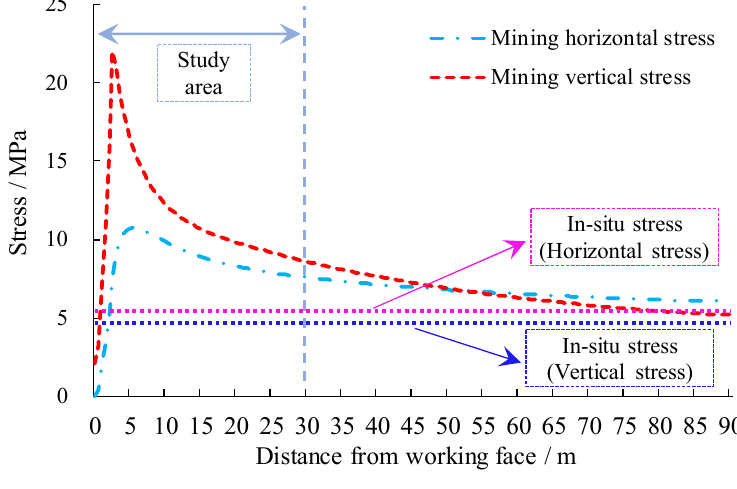
Figure 10. Mining stress distribution characteristics.